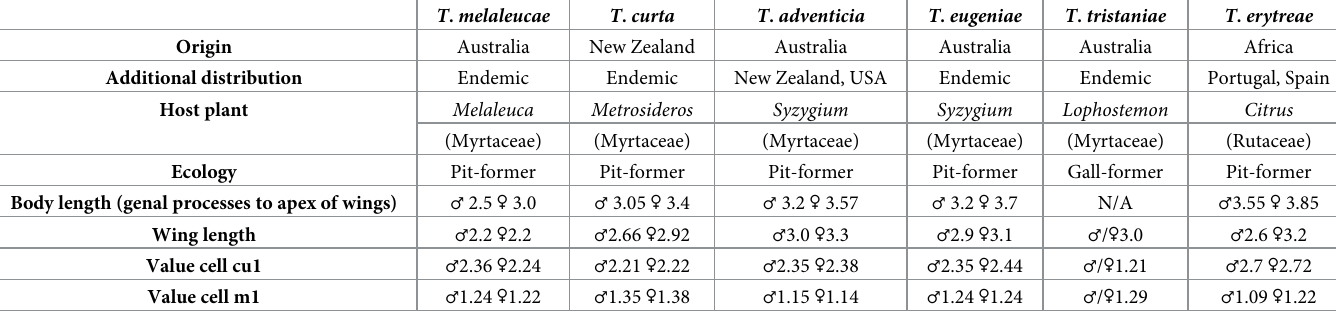
Table 1. Distributional, ecological and morphological data from the six Trioza species compared in this